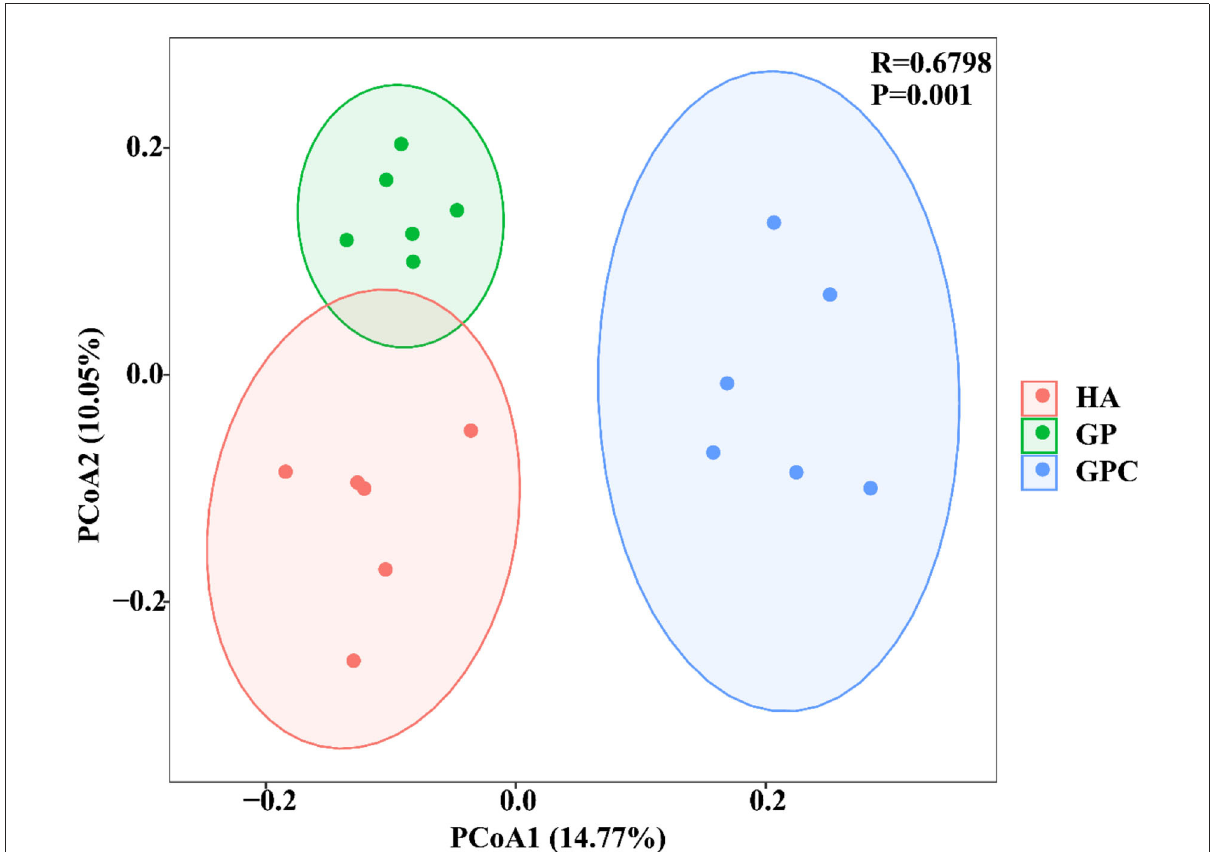
FIGURE2 Principal coordinate analysis (PCoA) of rumen microbial communities based on unweighted UniFrac distance ( n = 6). HA, non-pelleted native grass hay diet, GP, pelleted native grass hay diet; and GPC, pelleted native grass hay with concentrate